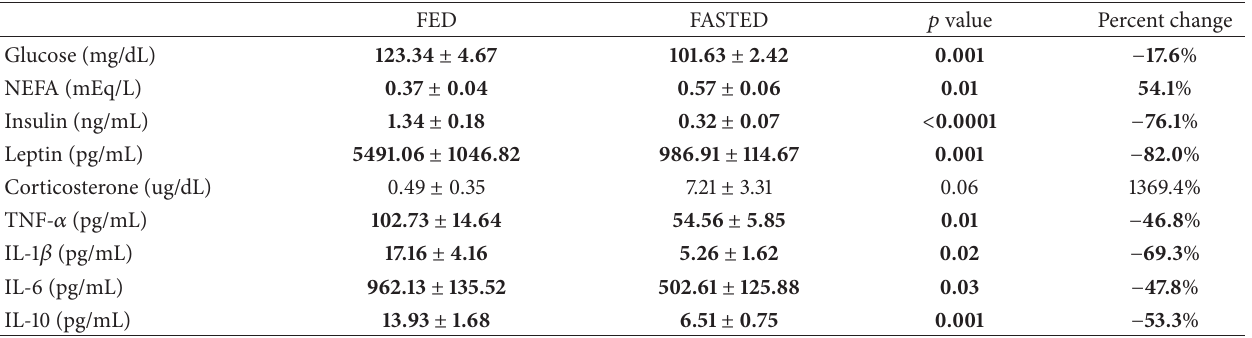
Table 1: Effects of a 24 h fast on basal markers of energy status and cytokine concentrations in blood plasma. Differences between blood plasma variables in fed (FED + 0IS, 𝑛 = 8 ) versus fasted (FASTED + 0IS, 𝑛 = 8 ) control rats by unpaired, 2-tailed 𝑡 -test. Values are expressed as means ±